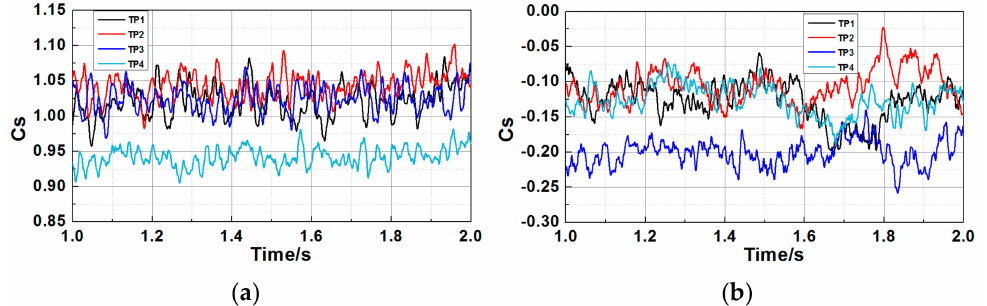
Figure 22. Cs on the head and tail in time domain: ( a ) head; ( b ) tail.